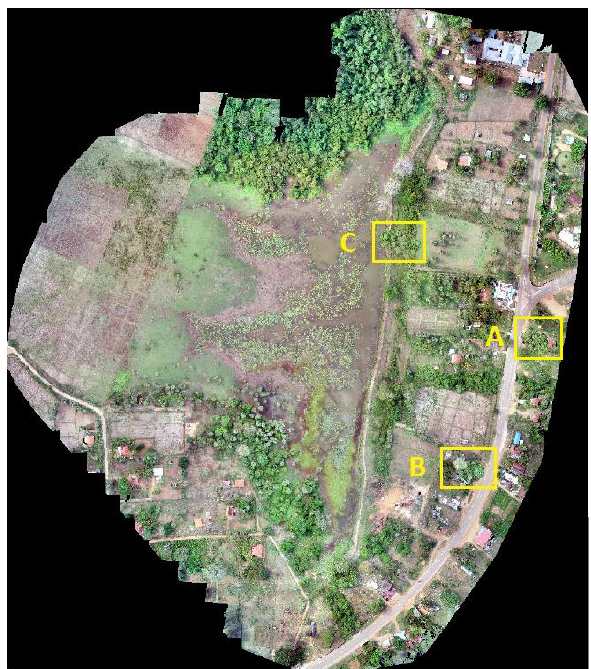
Figure 3: Ortho-mosaic of the study area (base